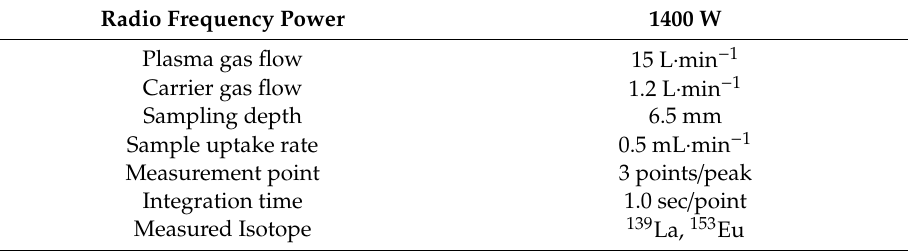
Table 1. Operating conditions of Inductively Coupled Plasma-Mass Spectrometry